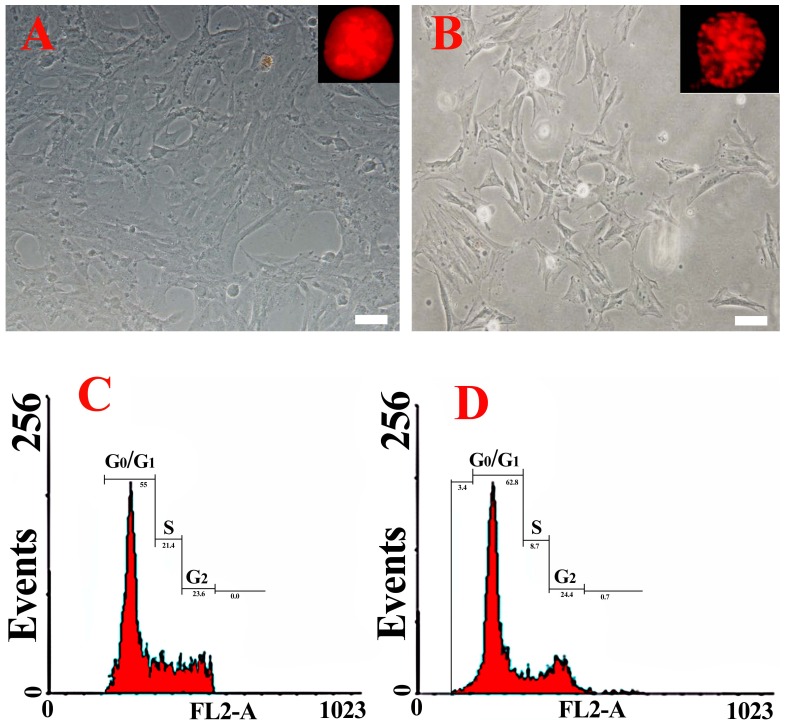
Morphology and cell cycle of the cells at 6th day after subculture in the medium with 120 mM or without trehalose.Cell morphology (A) and cell cycle (C) of the cells in IMDM with 120 mM trehalose; Morphology (B) and cell cycle (D) of the cells in IMDM without trehalose. Bar: 20 μm. Inserts in A, B showed morphology of cellular nuclear using PI staining under fluorescence microscopy (400×).